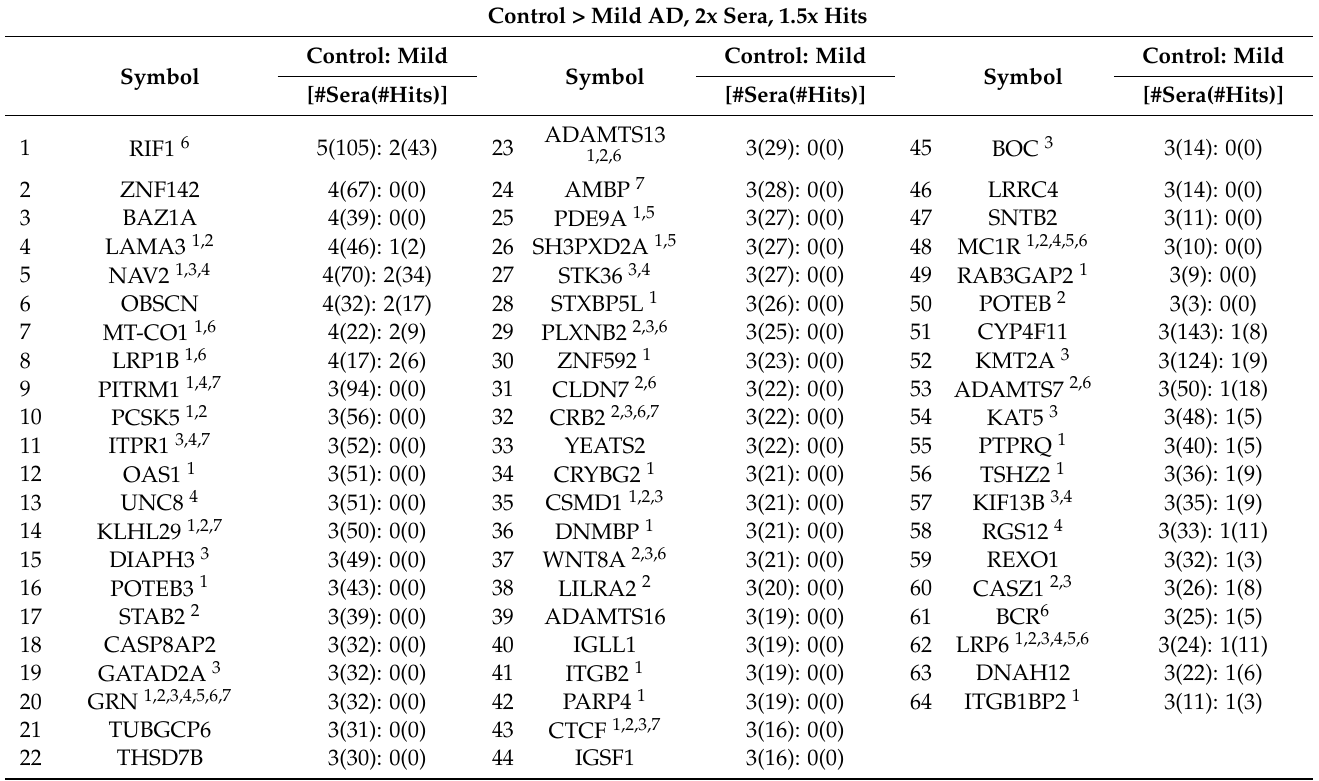
Table 4. Top 64 peptides/proteins from the control > mild AD subjects with 2x or better sera differences and 1.5x or better MS/MS “hit” numbers. Control > mild, 2x sera, 1.5x